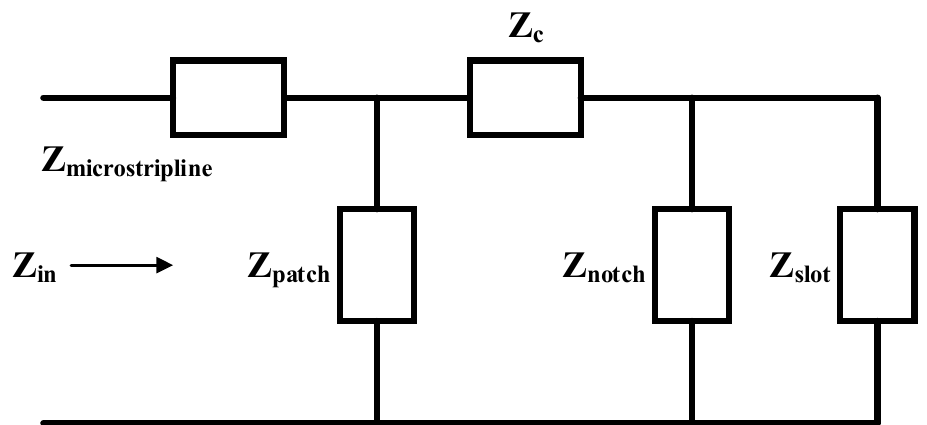
Figure 4. Equivalent circuit model of the proposed textile antenna.